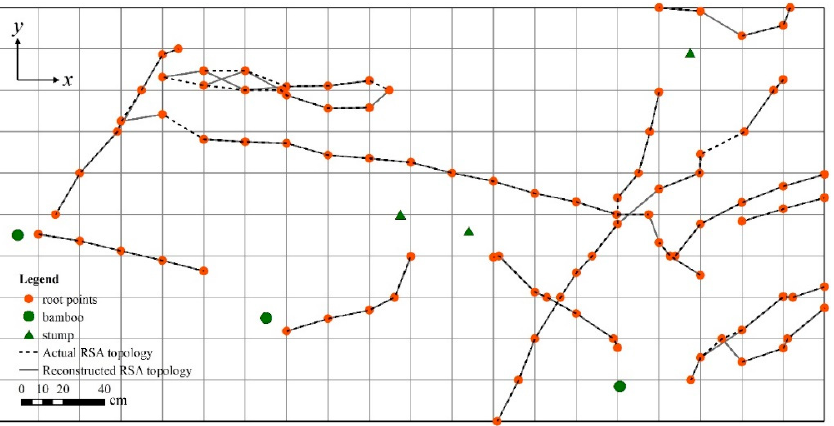
Figure 10. Comparison of the actual measured and the reconstructed topology of the rhizome system. Dashed lines represent the measured root system architecture (RSA) topology, which was obtained by directly connecting the measured root points (red circles). Solid line represents the RSA topology reconstructed using the algorithm.